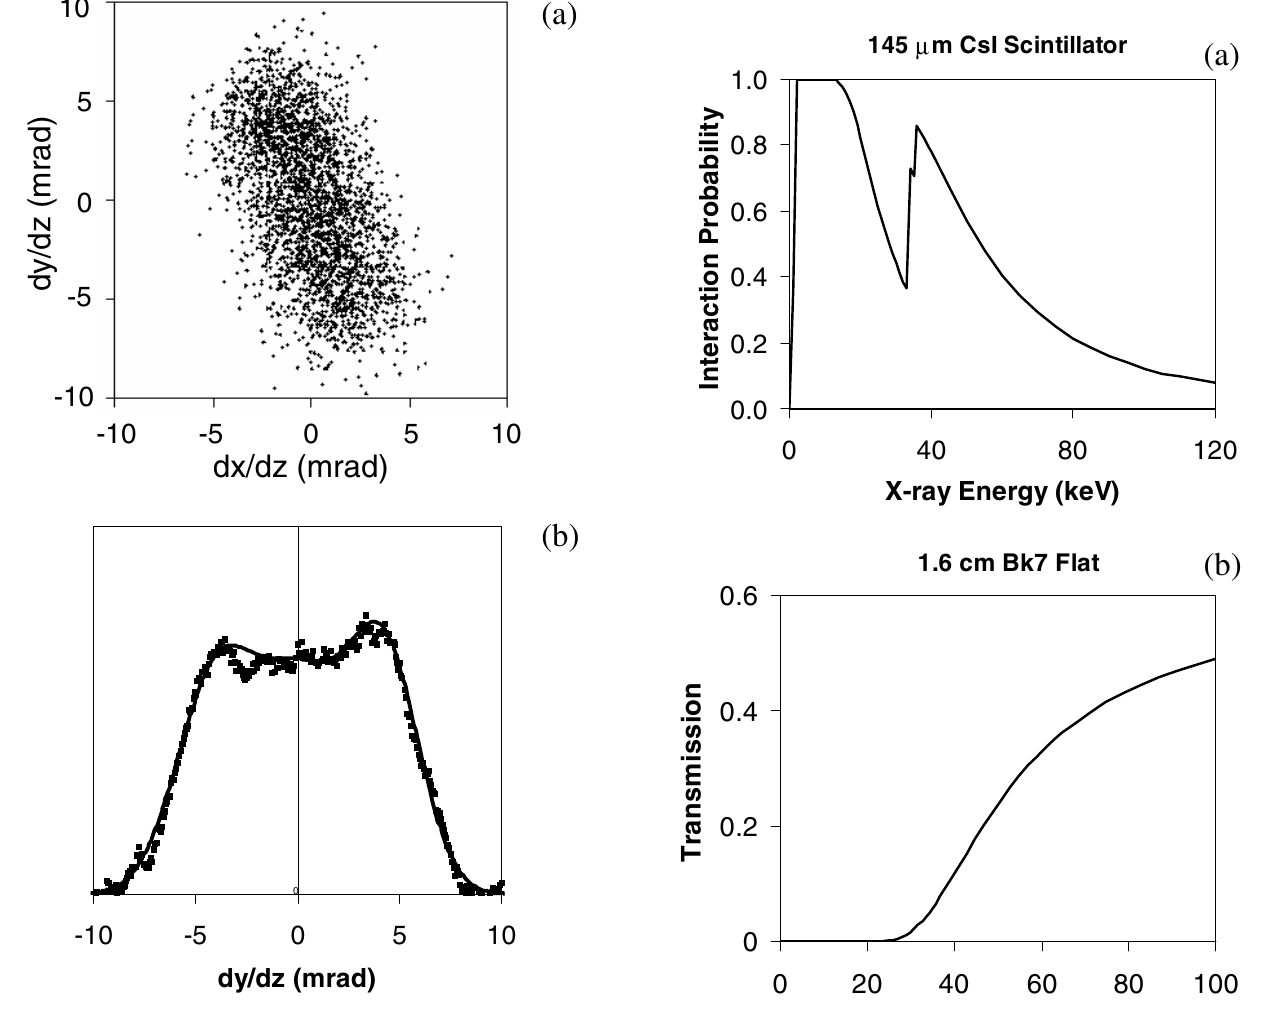
FIG. 4. Reconstructed macroparticle representation of the electron beam divergence (a), and (b) comparison of the measured x integrated electron beam divergence in y (squares) to the distribution function used to construct the macroparticle